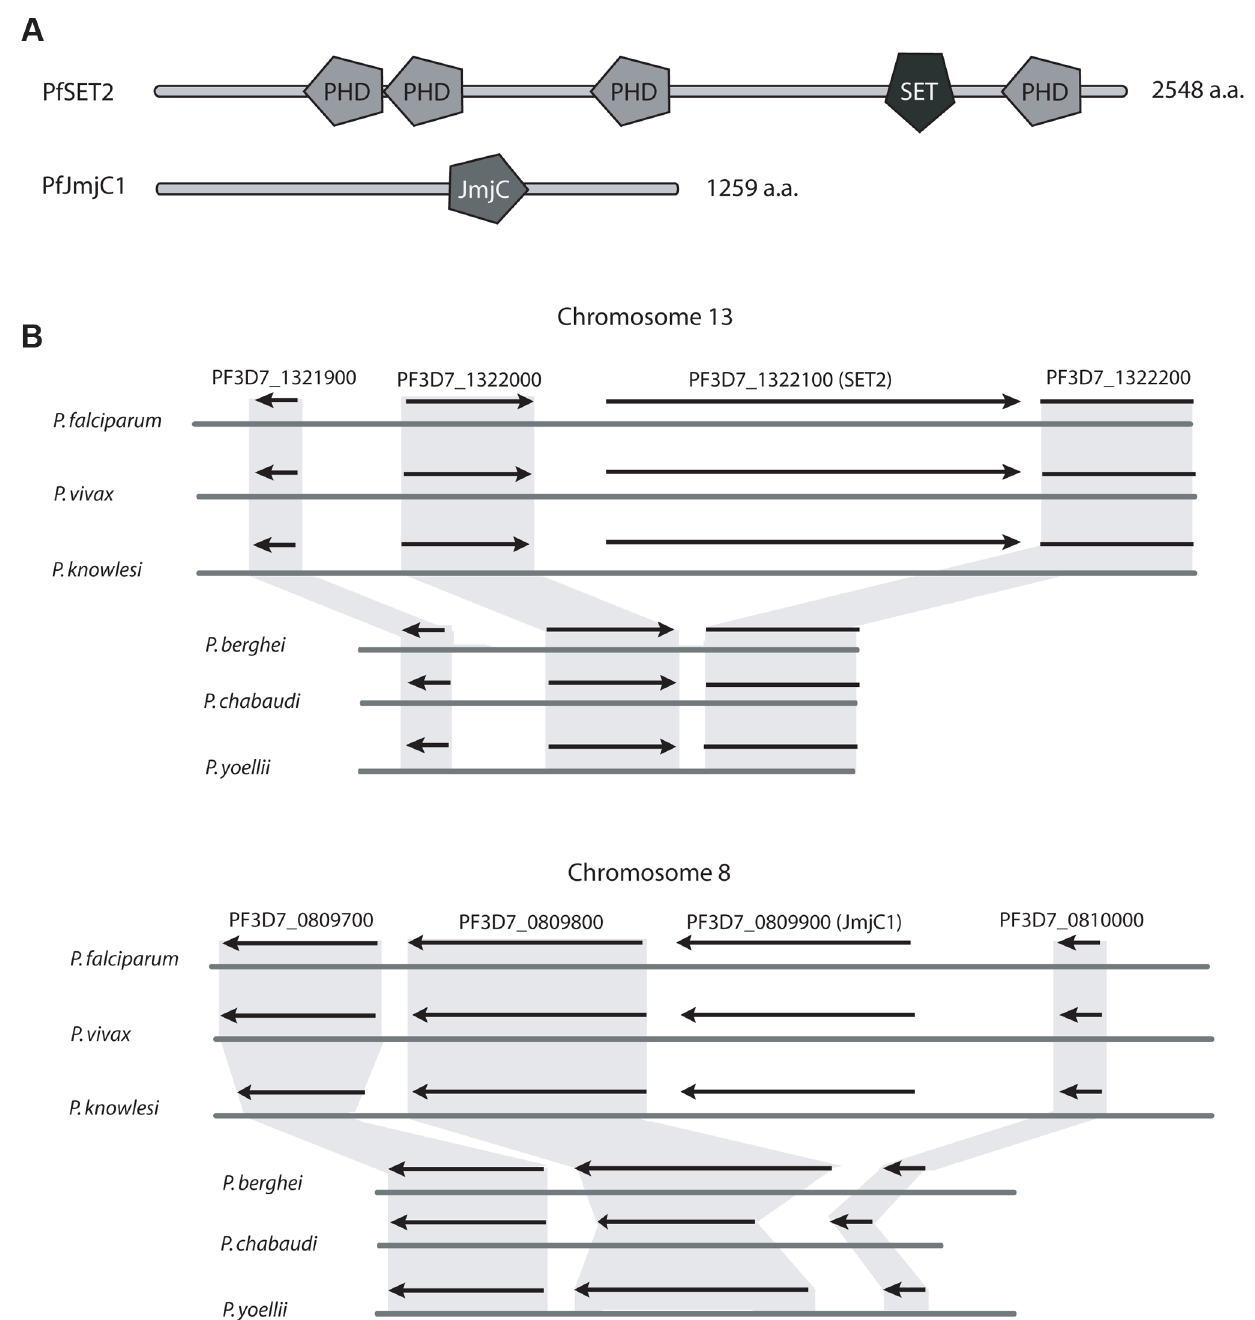
Figure 1. Two histone modifiers unique to primate parasites. A comparative screen of the genomes of primate and rodent malaria parasites identified two histone modifiers unique to P. falciparum , P. vivax and P. knowlesi , SET2 and JmjC1. (A) Domain searches of the amino acid sequences using SMART (Simple Modular Architecture Research Tool, http://smart.embl-heidelberg.de) identified several domains typical of chromatin modifying enzymes, including several PHD domains and a SET2-like methyltransferase domain in PfSET2 and a predicted JmjC type demethylase in PfJmjC1. (B) Syntenic regions of chromosomes 13 and 8 of three primate parasites and three rodent parasites. Extensive synteny is observed throughout these chromosomal regions, with the exception of SET2 and JmjC1, which are missing from the genomes of the rodent parasites. The flanking genes are highly conserved. Figure adapted from Plasmodb.org.